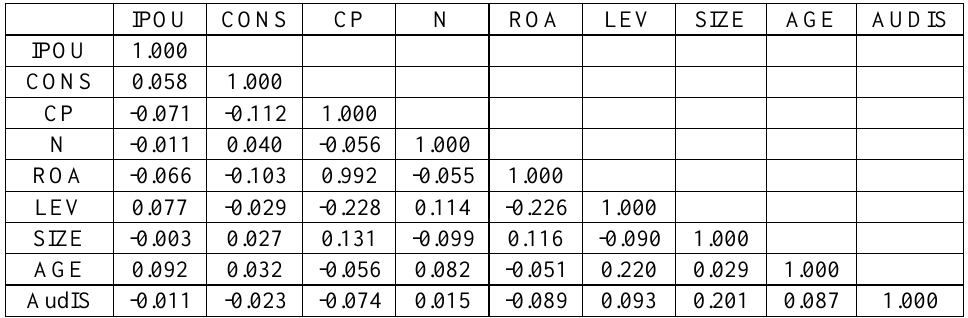
Table 4. Levin, Lin & Chu t, Null: Unit root (assumes common unit root process) Variables